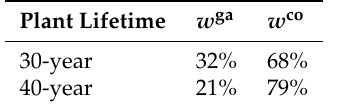
Table 9. The composition of efficient portfolios with zero expected NPV. The two-asset case. The composition is the same under both the standard deviation and the CVaR deviation risk measures.